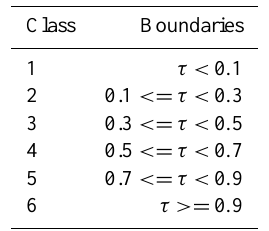
Table 1. Boundaries to select different vegetation optical depth ( τ )